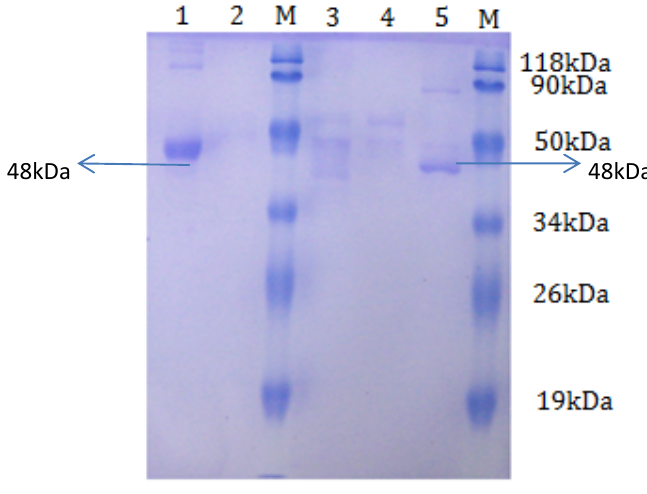
Figure 4. SDS-PAGE analysis of purified β 6-1 and β 6-2. Lane M represents the low- molecular-weight marker. Lane 1 represents the purified product of pET β 6-1 recombinant protein. Lanes 2 and 3 represent the purified product of the non-induced control culture. Lane 4 represents the purified product of the vector control culture. Lane 5 represents the purified product of pET β 6-2 recombinant